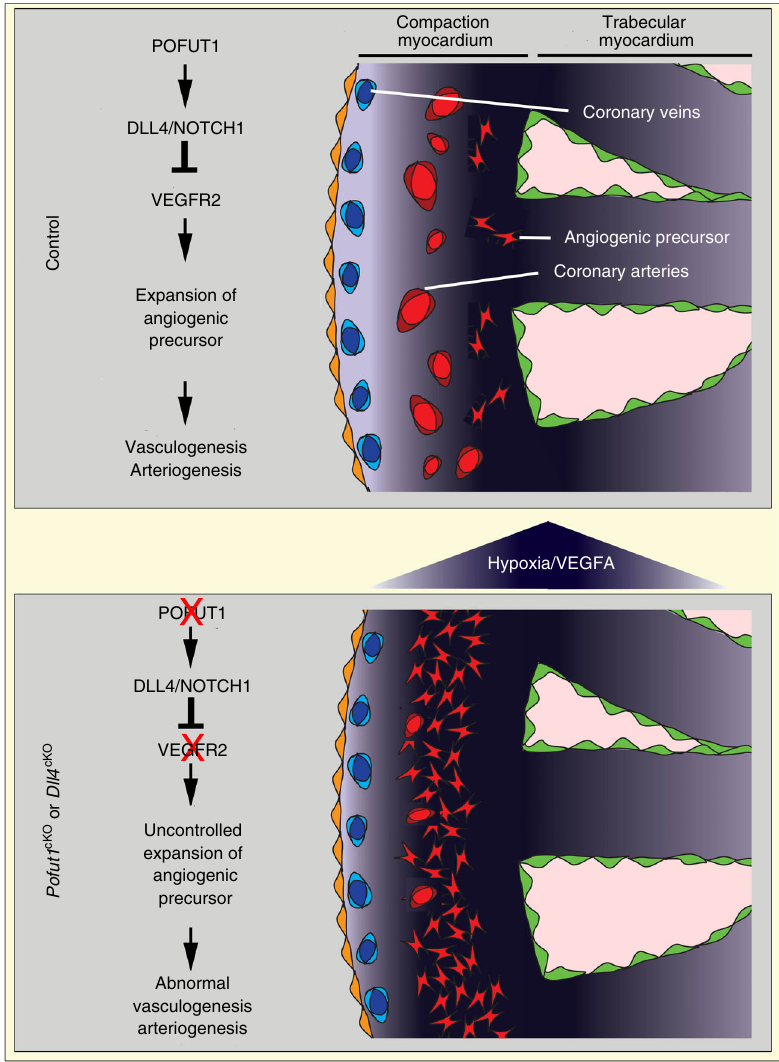
Fig. 7 POFUT1 regulates proliferation and angiogenic functions of precursor cells for coronary artery development. During coronary artery development, coronary angiogenic precursor cells give rise to coronary arterial plexuses in the hypoxic and VEGFA-rich inner myocardium by vasculogenesis. These plexuses then invade and fuse to form coronary arteries in the outer myocardium through arteriogenesis. Proliferation of coronary angiogenic cells during coronary vasculogenesis is modulated by POFUT1/DLL4/NOTCH1/VEGFA/VEGFR2 signaling axis. Deletion of Pofut1 suppresses DLL4/NOTCH1 signaling, which in turn elevates VEGFA/VEGFR2 signaling. Augmented VEGFA/VEGFR2 signaling promotes proliferation and angiogenic functions of coronary precursor cells, resulting in excessive non-functional coronary plexuses, which are unable to mature into coronary